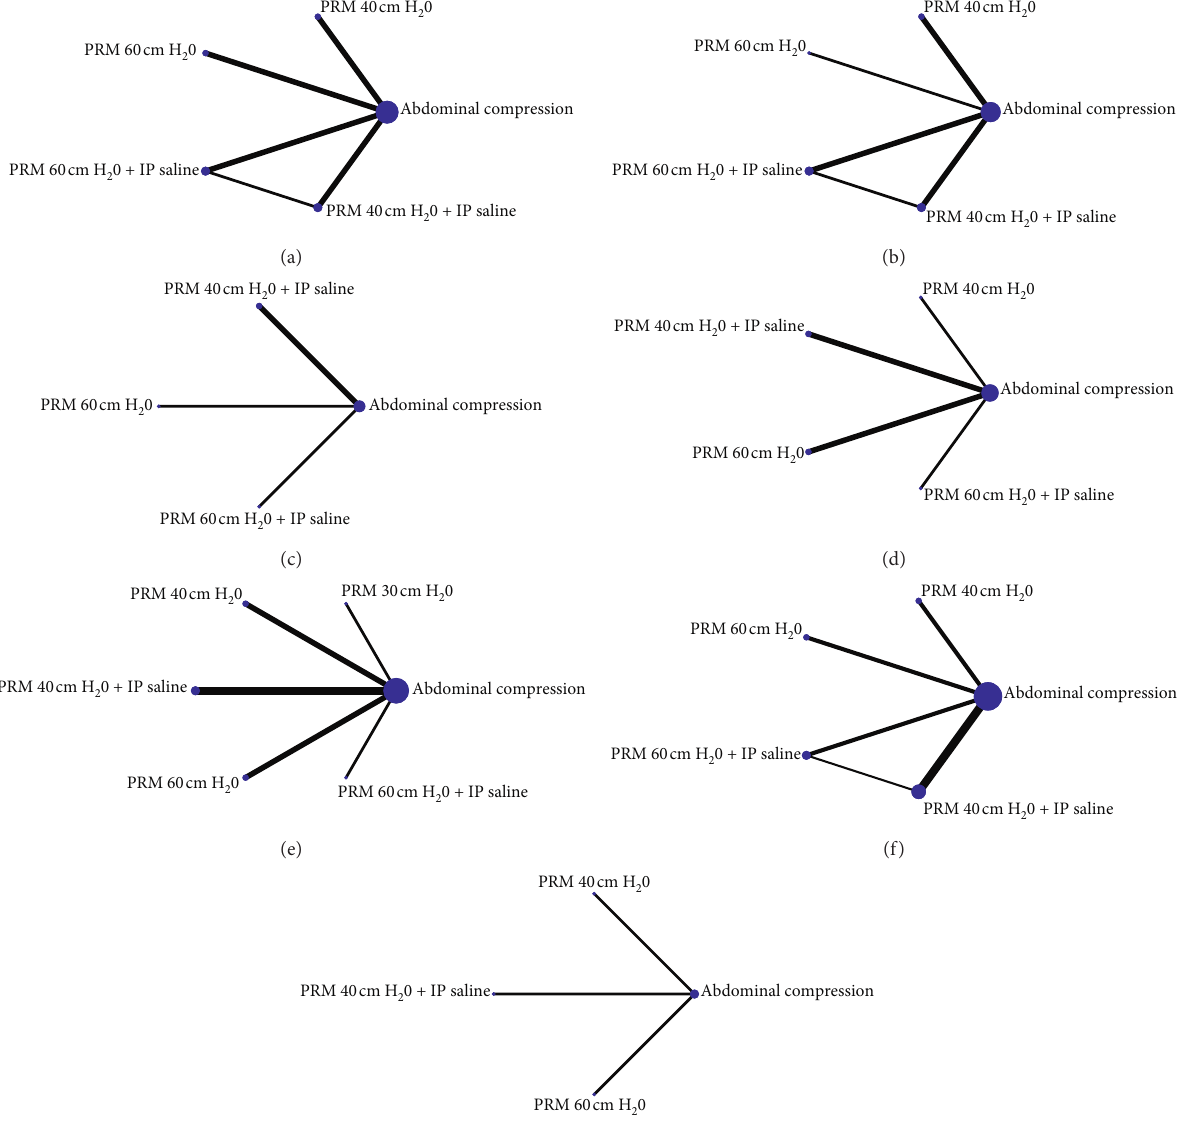
Figure 3: Network geometry of outcomes (Abd: abdominal compression, PRM 40: pulmonary recruitment maneuver 40cm H pulmonary recruitment maneuver 60cm H 2 O, IP saline: intraperitoneal saline): (a) intensity of shoulder pain at 24 hours, (b) intensity of shoulder pain at 48 hours, (c) incidence of shoulder pain at 24 hours, (d) incidence of shoulder pain at 48 hours, (e) postoperative nausea/ vomiting, (f) cardiopulmonary complications, and (g) requirement of postoperative